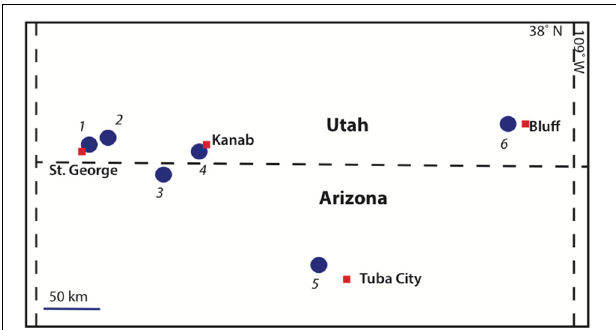
FIGURE 2 | Location map showing sampling locations. The east-west dashed line is the boundary between Utah and Arizona. Blue circles indicate sampling locations. 1. Washington Dome & Warner Valley, near St. George, UT; 2. Leeds/Historic Babylon, UT; 3. Potter Canyon, AZ;